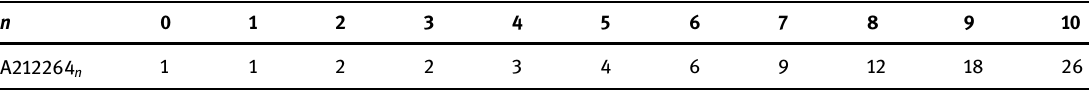
Table 1: The fi rst few values of A212264 n